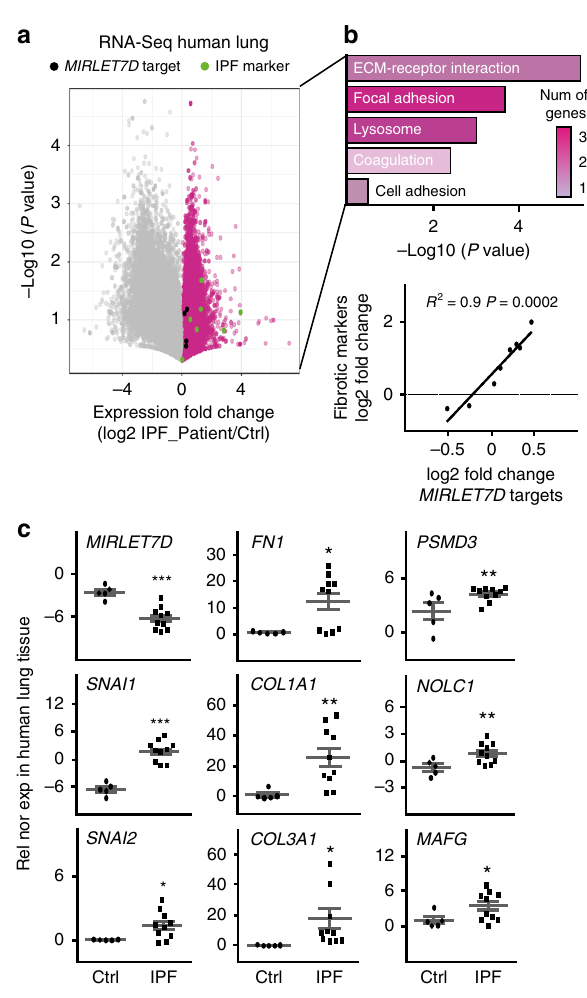
Fig. 1 Nuclear MIRLET7D targets can be used as novel IPF markers. a RNA- sequencing in lung homogenates from Ctrl and IPF patients 31 . Volcano plot representing the signi fi cance ( − log10 P -values after Welch ’ s t -test) vs. expression fold change (log2 expression ratios) between average of Ctrl and two IPF patients. Magenta dots show transcripts with positive log2 expression ratios. Black dots show MIRLET7D targets. Green dots show fi brotic markers. b Top: KEGG-based enrichment analysis of transcripts upregulated in both IPF patients (magenta dots in a ) using DAVID bioinformatics tool and plotted by highest signi fi cance ( − log10 of modi fi ed Fisher ’ s exact P -value). Color of the bar represents number of genes in each group based on the legend. ECM, extracellular matrix. Bottom: correlation analysis between MIRLET7D targets and fi brotic by linear regression of log2 FC value of a single MIRLET7D target paired with a single fi brotic marker from the two selected patients. All values were patient-matched and correlation clustering (data mining) from negative to positive values. c Mature MIRLET7D -speci fi c TaqMan assay and qRT-PCR analysis of the indicated coding RNAs (cRNA) using total lung homogenates from Ctrl ( n = 5 biologically independent samples) and IPF patients ( n = 10 biologically independent samples). Data are shown as means± SEM. Asterisks in all plots, P -values after unpaired t -test, one-tailed, *** P < 0.001; ** P < 0.01; * P < 0.05. Source data are provided as a Source Data fi